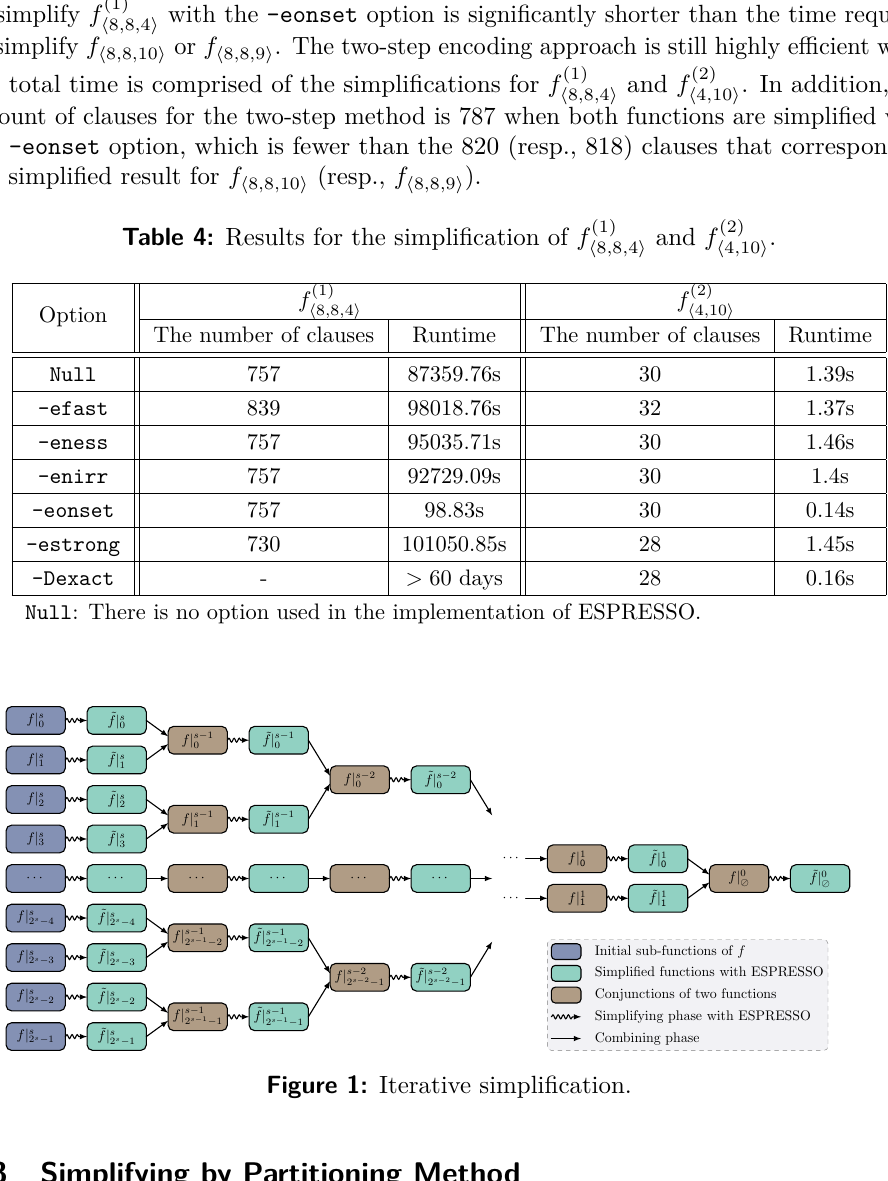
Table 4: Results for the simplification of f (1)